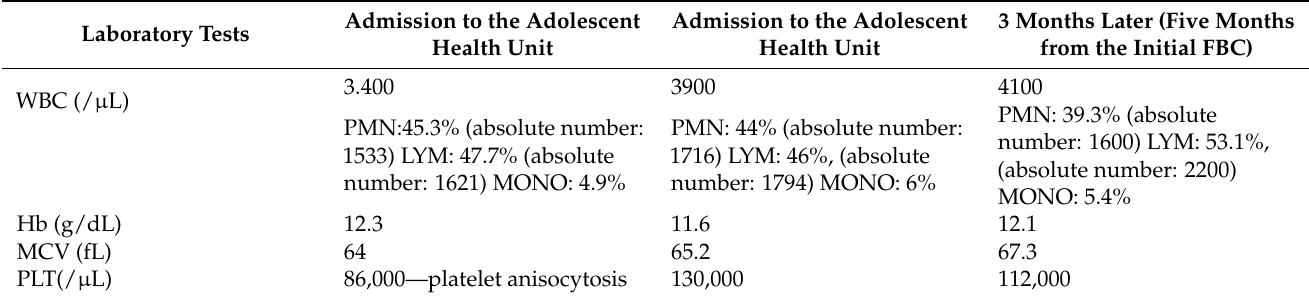
Table 2. Full blood count (FBC) on admission, discharge, and 3 months